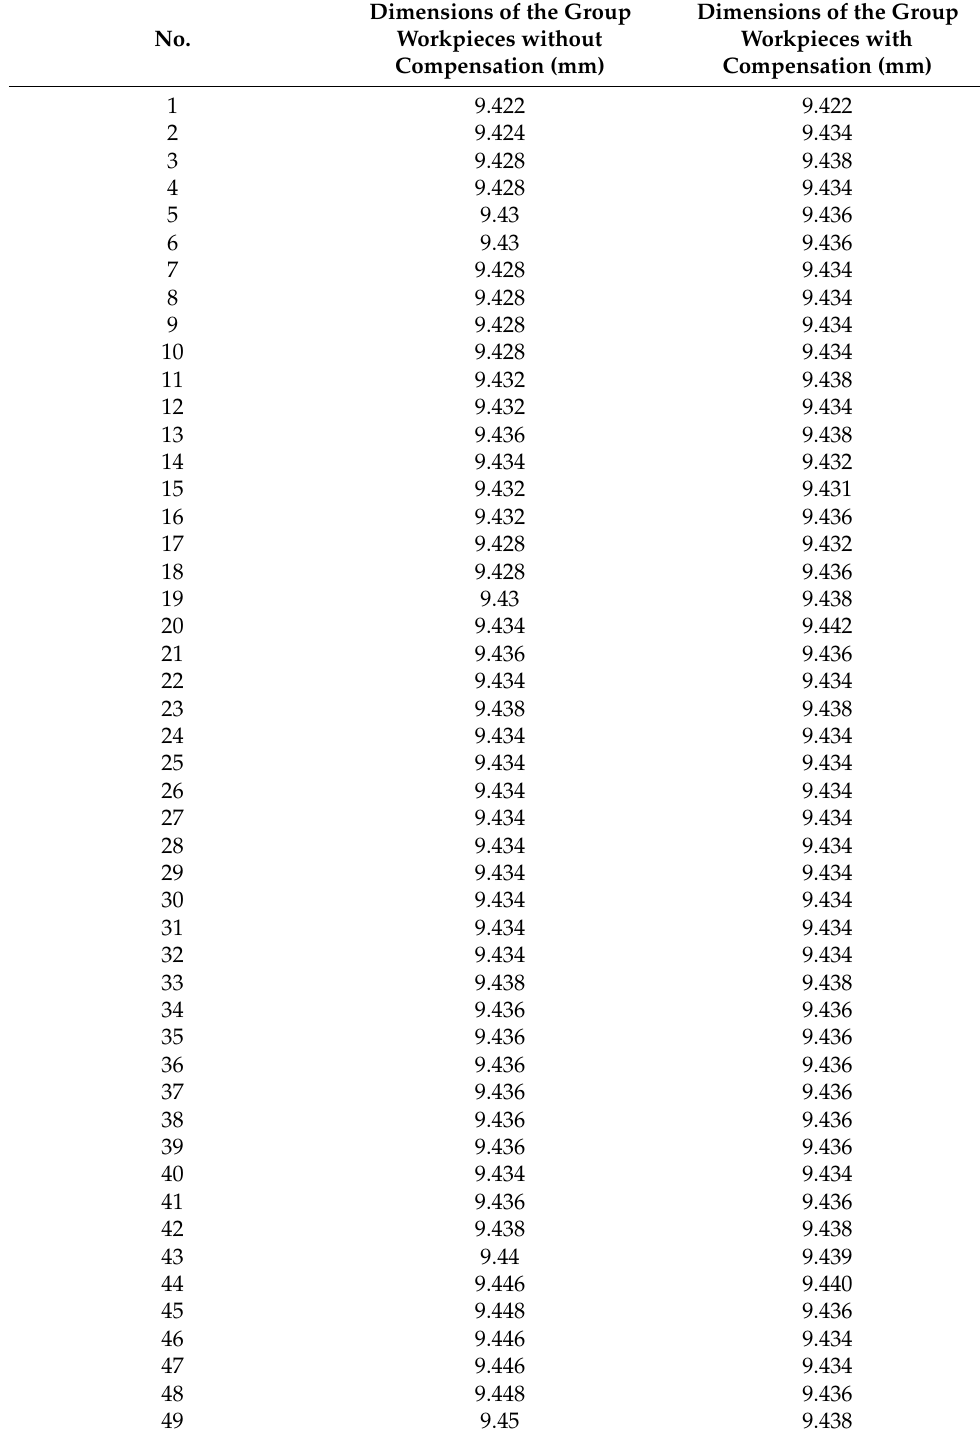
Table 2. Dimensions of the machined workpieces before and after compensation.